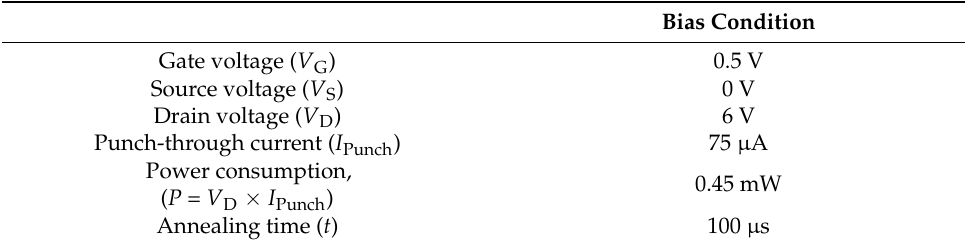
Table 2. Bias conditions for punch-through current based ETA.